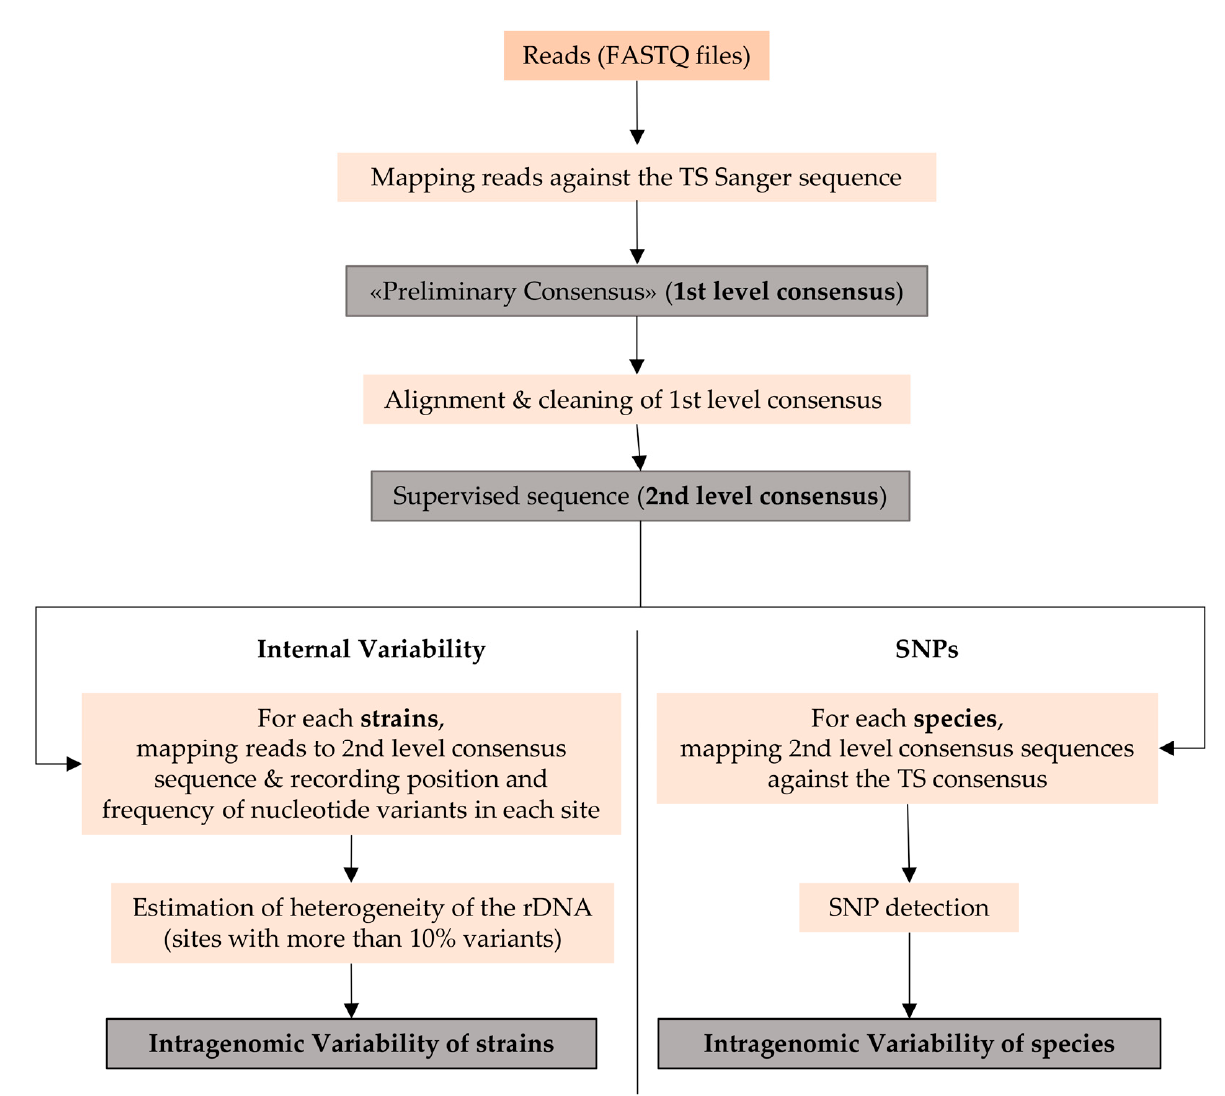
Figure 1. Steps in variant sites analysis.